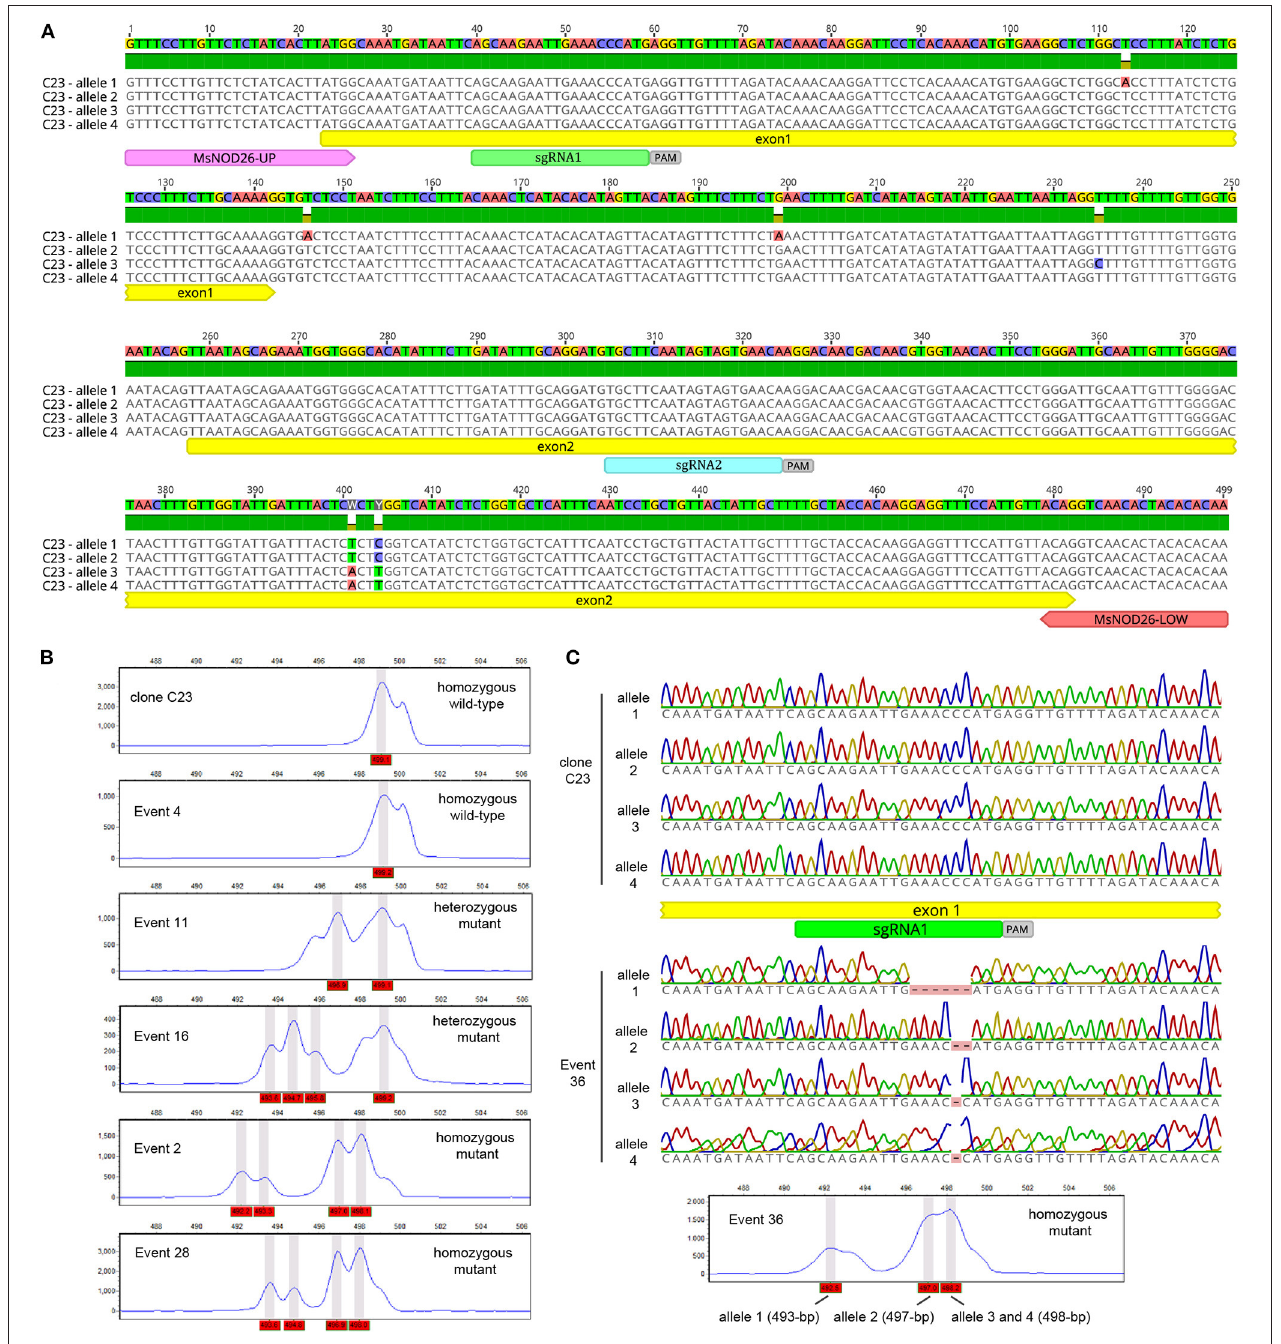
FIGURE 2 | (A) Nucleotide sequence of wild-type alleles of MsNOD26 gene (MSAD_247675) from clone C23. In this picture, we highlighted the first two exons (exon1 and exon2), the two guides (sgRNA1 and sgRNA2) and the sequence recognized by the Cas9 nuclease (PAM sequences) and the primers ( MsNOD26 -up and MsNOD26 -low) used for the identification of edited events using high-resolution fragment assays. (B) Flow cytometry fluorescence intensities of wild-type (499-bp) and mutant (492–498 bp) alleles of MsNOD26 gene. This figure shows representative examples of different genotypes. (C) Sequence analysis showed small deletions (1, 2, and 6-bp) within the alleles of MsNOD26 gene in CRISPR/Cas9-editing event 36.